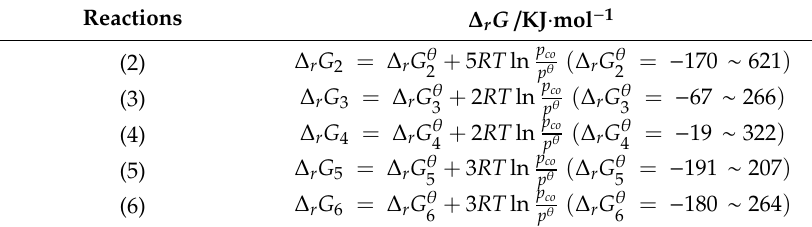
Table 2. Main possible reactions and their Gibbs free energies ( ∆ r G